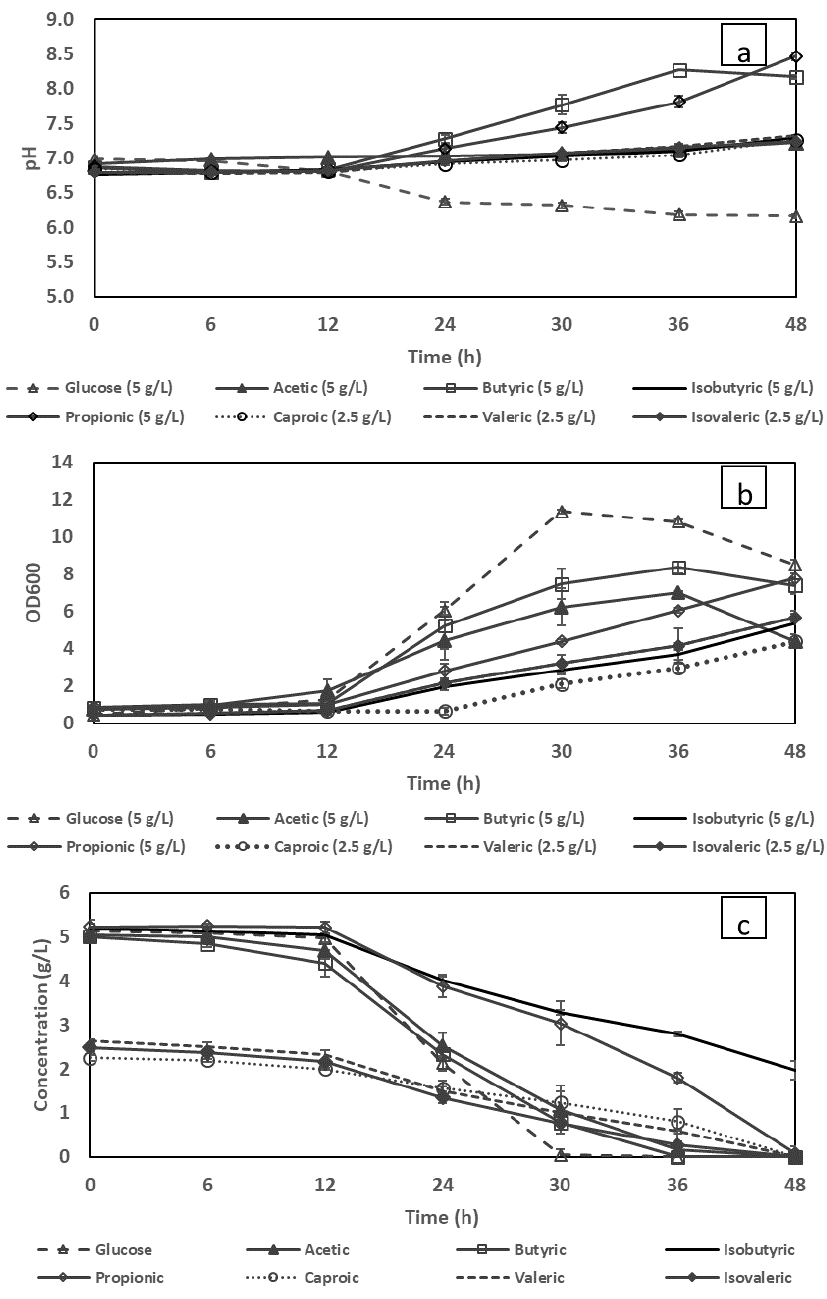
Figure 1. Changes in the pH ( a ), cell density ( b ) and volatile fatty acid ( c ) concentration during batch cultivation using glucose and individual VFAs as a sole carbon